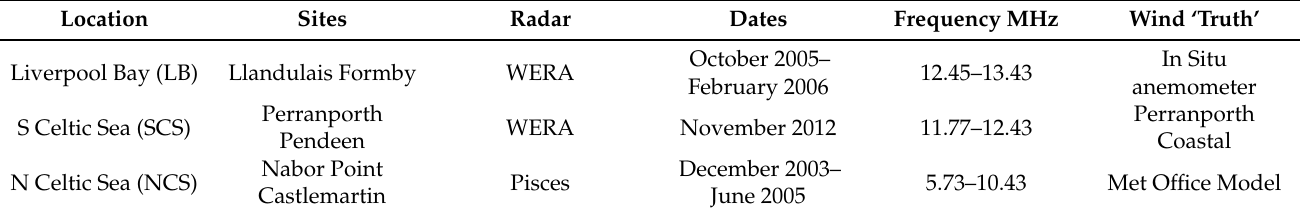
Table 2. Radar, training and validation data